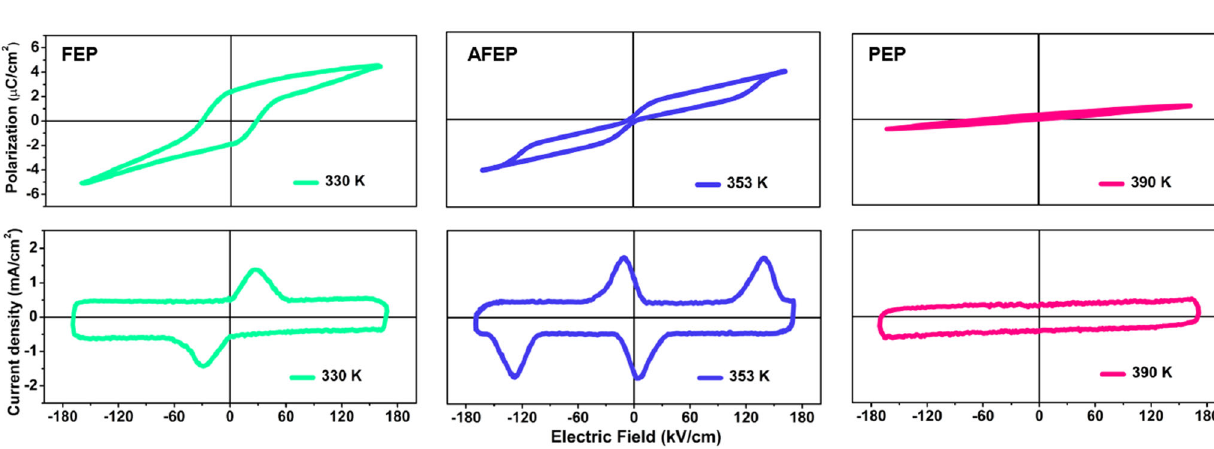
Fig.5|Thecharacteristicsof P-E hysteresisloopsand J-E curvesmeasuredoncrystalsof1atdifferenttemperatures. DuringthesuccessiveFE-AFE-paraelectricphase transitions of 1 , the hysteresis loops exhibit single (330K), double (353K) and linear (390K)